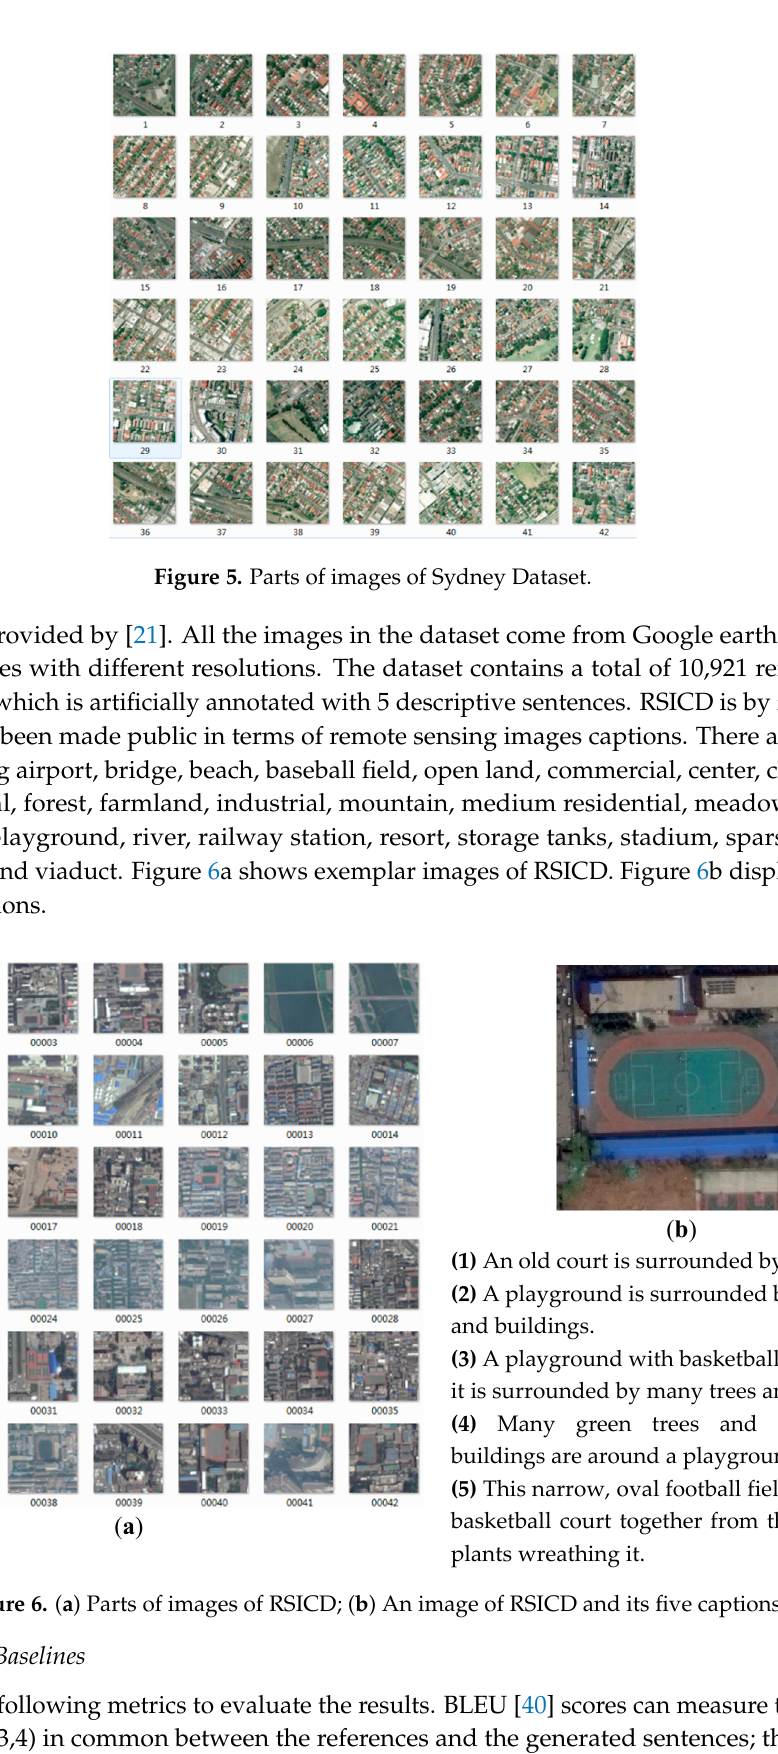
Figure 4. Parts of images of UCM Dataset.